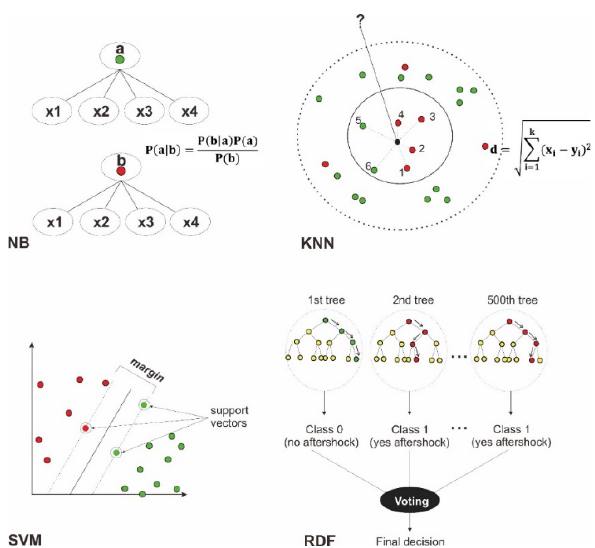
Figure 4. Schematic illustration of four ML methods. Red and green circles are “aftershock” and “not an aftershock,” respectively. In the NB model, x 1 , x 2 , ... are explanatory variables. The KNN model shows a simple illustration of how the close circles in a defined area can predict an unknown circle (black circle). The SVM model shows the contribution of the support vectors in the hyperplane for the prediction. The RDF model (formed using 500 decision trees) shows how the final classification of each tree is utilized in a majority voting process.